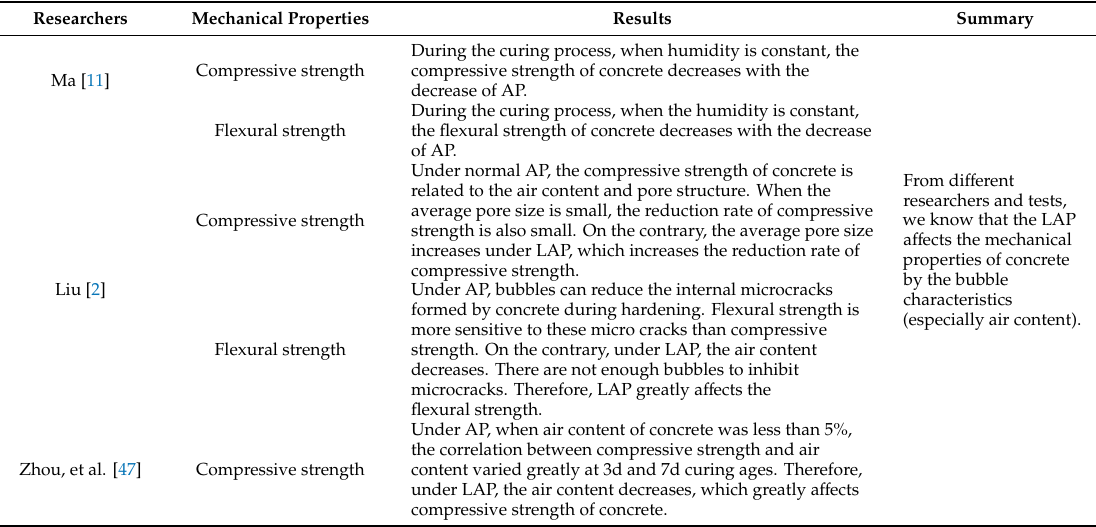
Table 9. Influence of normal AP / LAP on the mechanical properties of